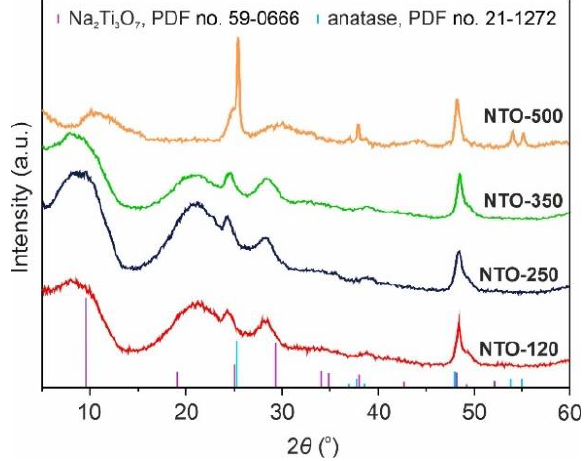
Figure 1. XRD patterns of Na 2 Ti 3 O 7 -based products prepared at different temperatures (120–500 °C) NTO-120, NTO-250, NTO-350, and NTO-500 products.